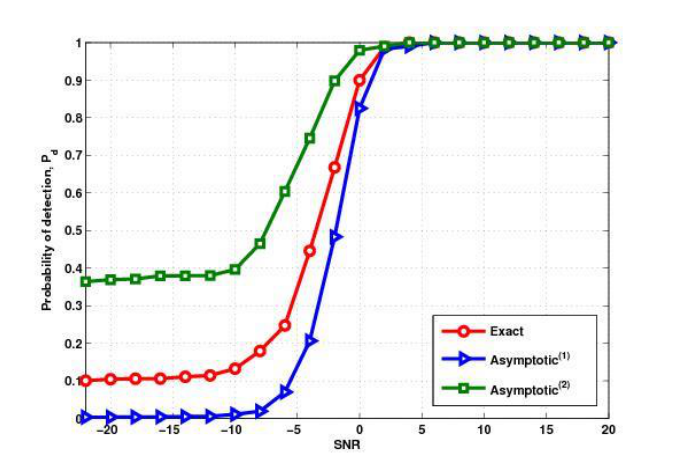
Figure 3. Probability of false alarm vs exact threshold for